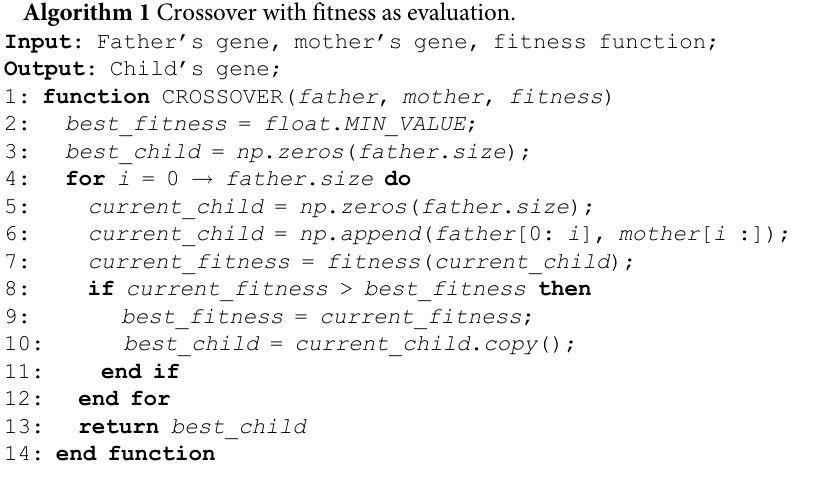
Algorithm 1 Crossover with fitness as